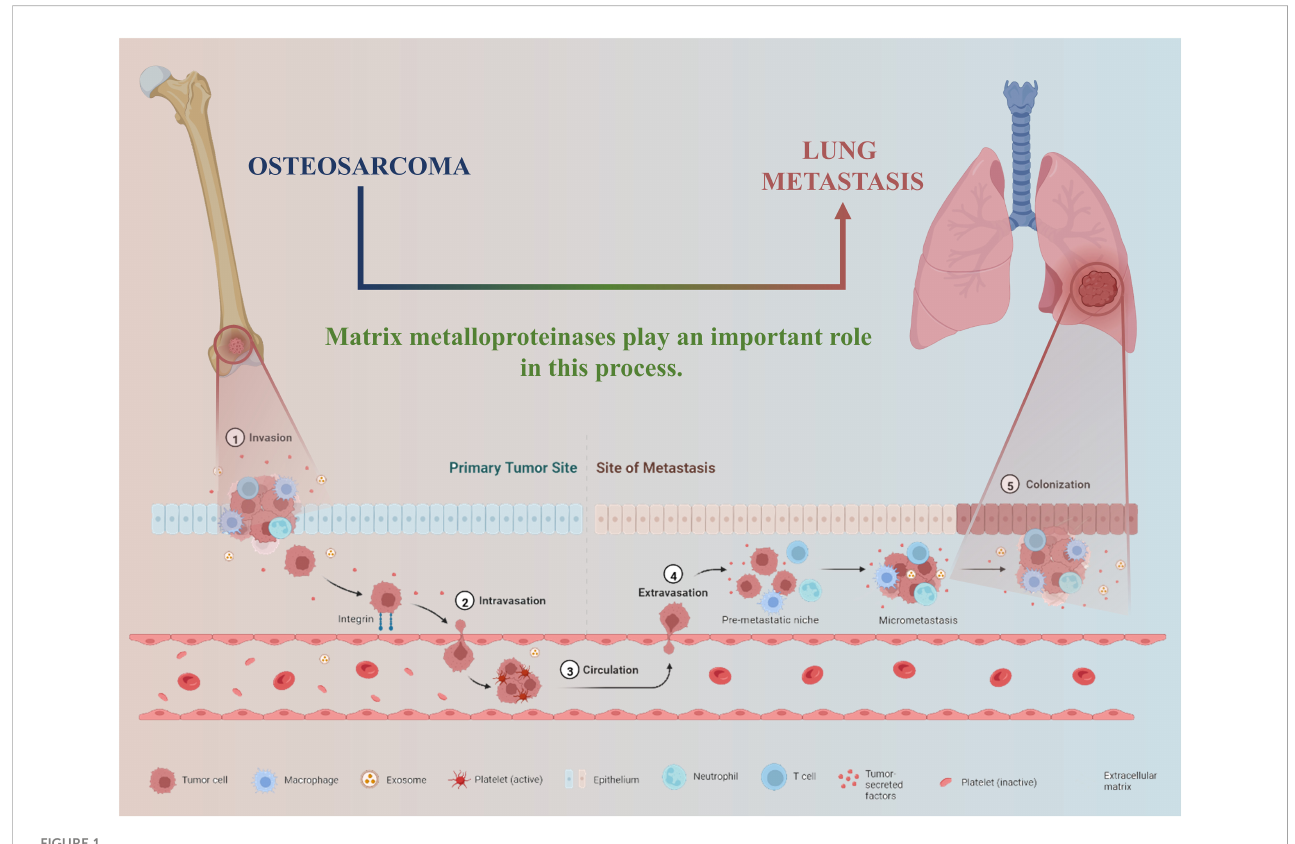
FIGURE 1 The emerging hot spot of the role of Metalloproteinase in OS may be to promote invasion and